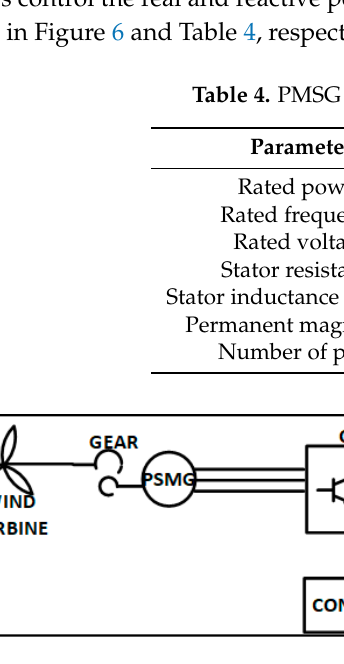
Figure 6. Schematic diagram of the PSMG.